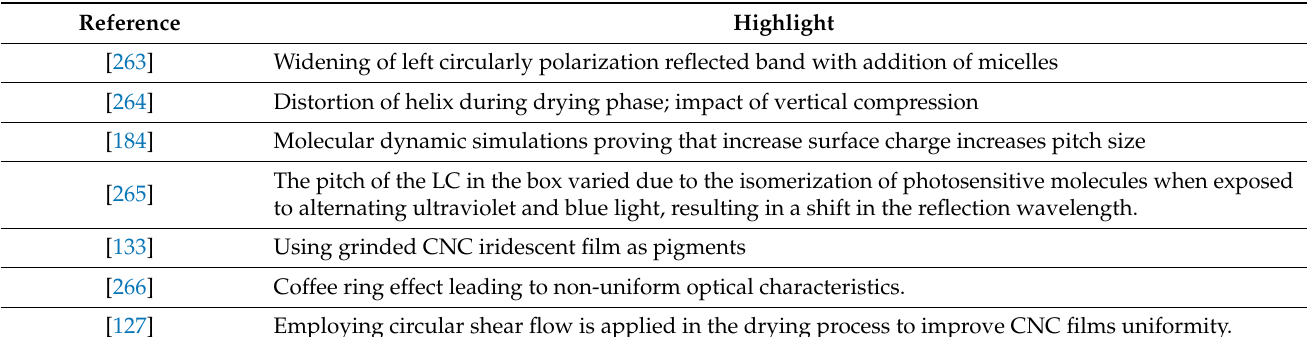
Table 3. Modulation of optical properties of CNC pure and composite films using references and